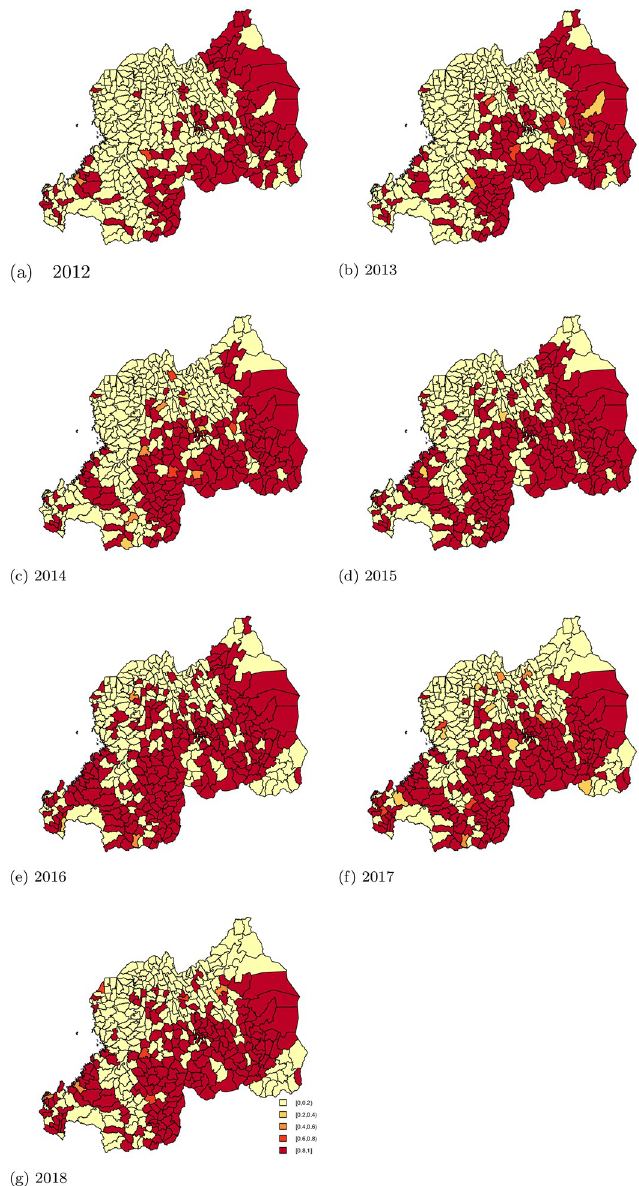
Fig 5. The area-specific probability of not reaching the target goal of 2018 (reduction of 42% as compared to